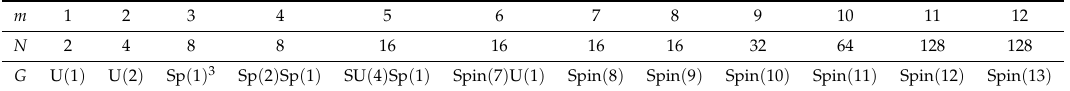
Table 3. Clifford systems C m and G -structures on Riemannian manifolds ( M N